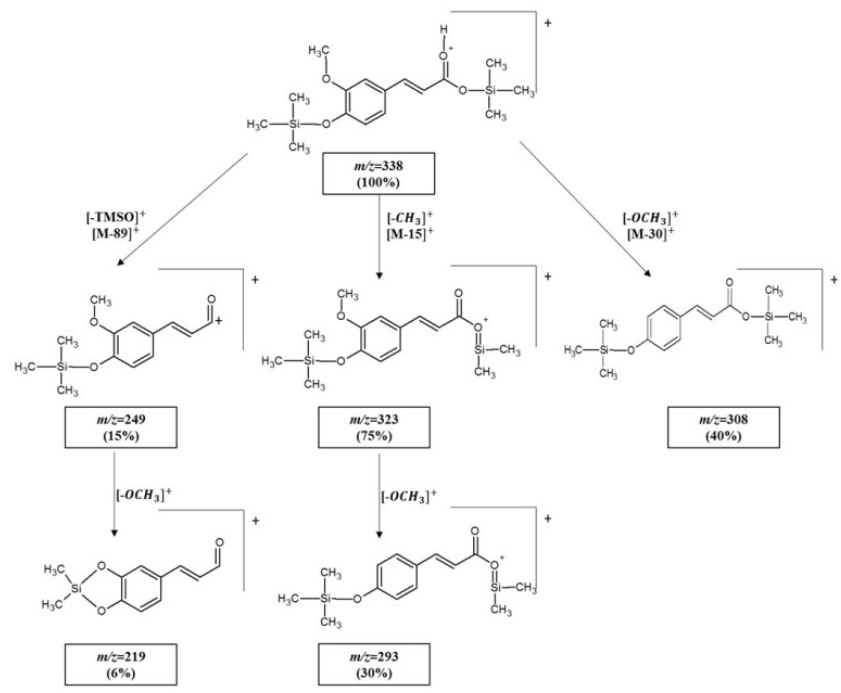
Figure 3. Proposed fragmentation pathway of the trans -FA-2-TMS derivative obtained under posi- tive EI + conditions. EI +